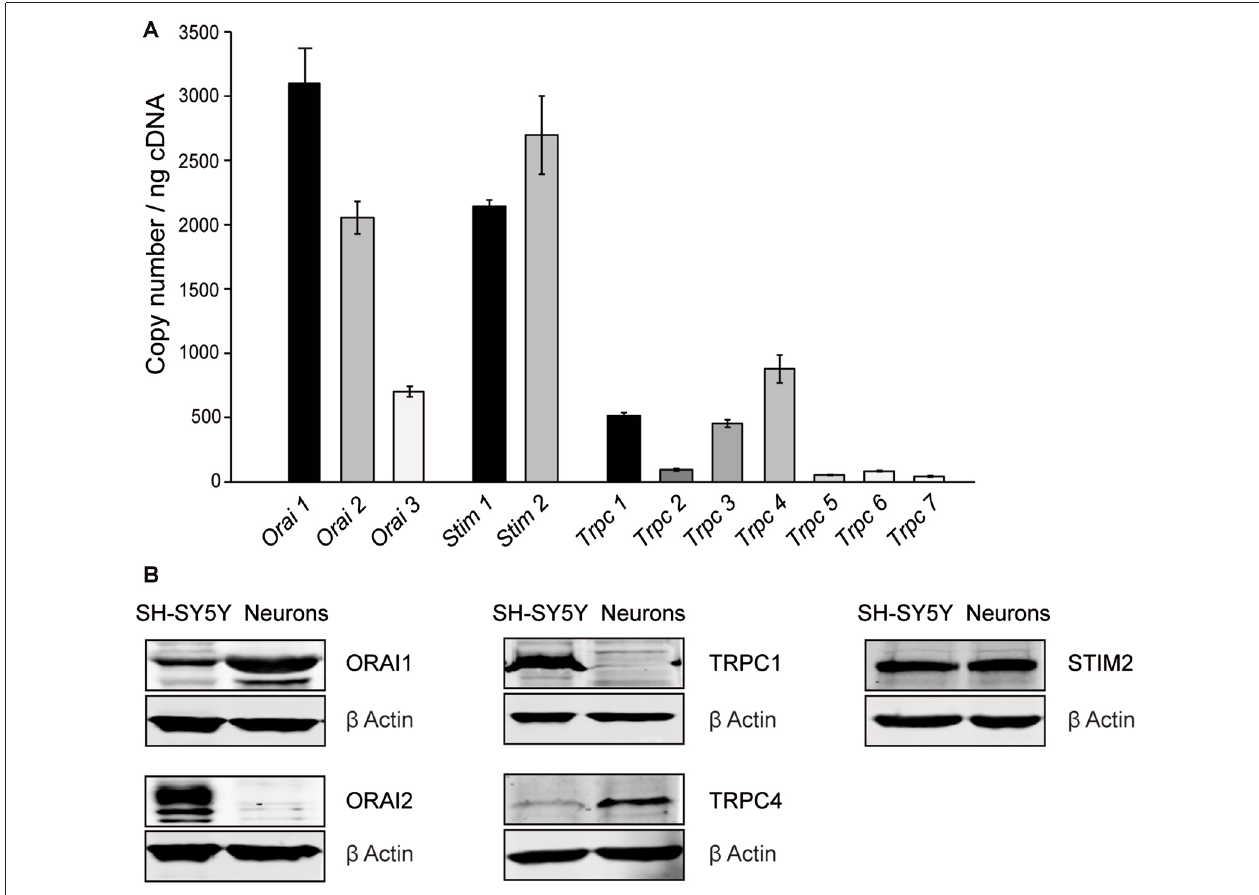
FIGURE 2 | SOC channel proteins in mouse cortical neurons. (A) Real time PCR (RT-PCR) of DNA complementary from primary cortical neurons obtained from E-15 wild-type mouse embryo with Orai 1–3, Stim 1, 2 and Trpc 1–7 specific primers. The experiment was repeated four times with similar results. (B) Western Blot analysis of ORAI 1, ORAI 2, STIM 2, TRPC 1 and TRPC 4 levels. Protein extracts were obtained from SH-SY5Y cells and 8–9 day in vitro (DIV) cortical neurons. Primary antibodies used were α -Orai1, α -Orai2, α -Trpc1, α -Trpc4, α -Stim2 and α - β Actin as a